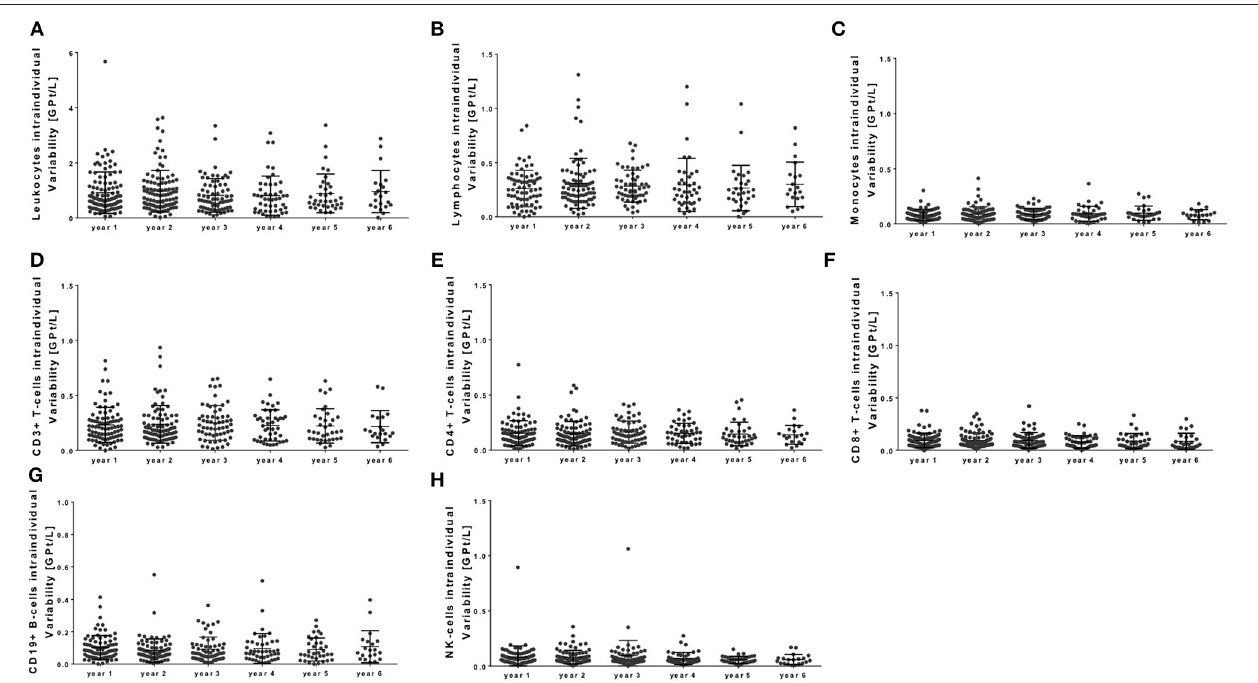
FIGURE 5 | Intra-individual variability of peripheral immune cell subsets during NAT treatment. Intra-individual variation of leukocytes (A) , lymphocytes (B) , monocytes (C) , CD3 + T cells (D) , CD4 + T cells (E) , CD8 + T cells (F) , CD19 + B cells (G), and NK cells (H) are depicted for each year. Intra-individual variability was defined as the standard deviation of absolute cell counts every 3 months in every year after NAT start (starting at month 3). Mean ± standard